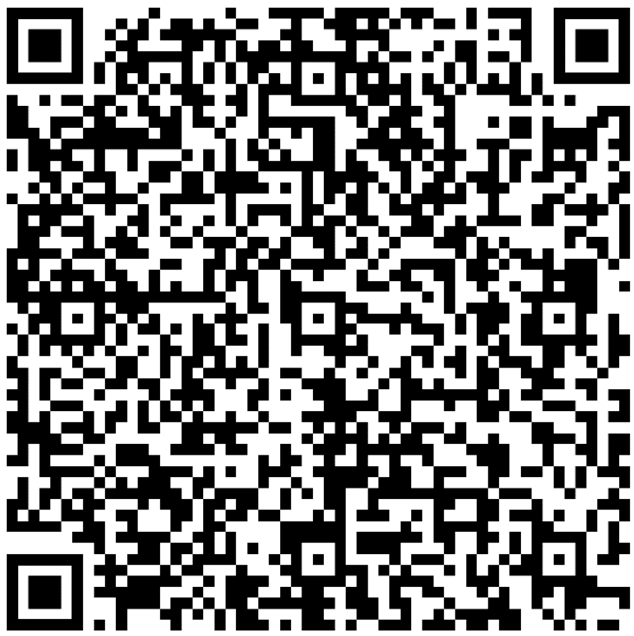
Figure 8. Istituto Luce, The architect Brasini in his house next to the model of one of his projects.